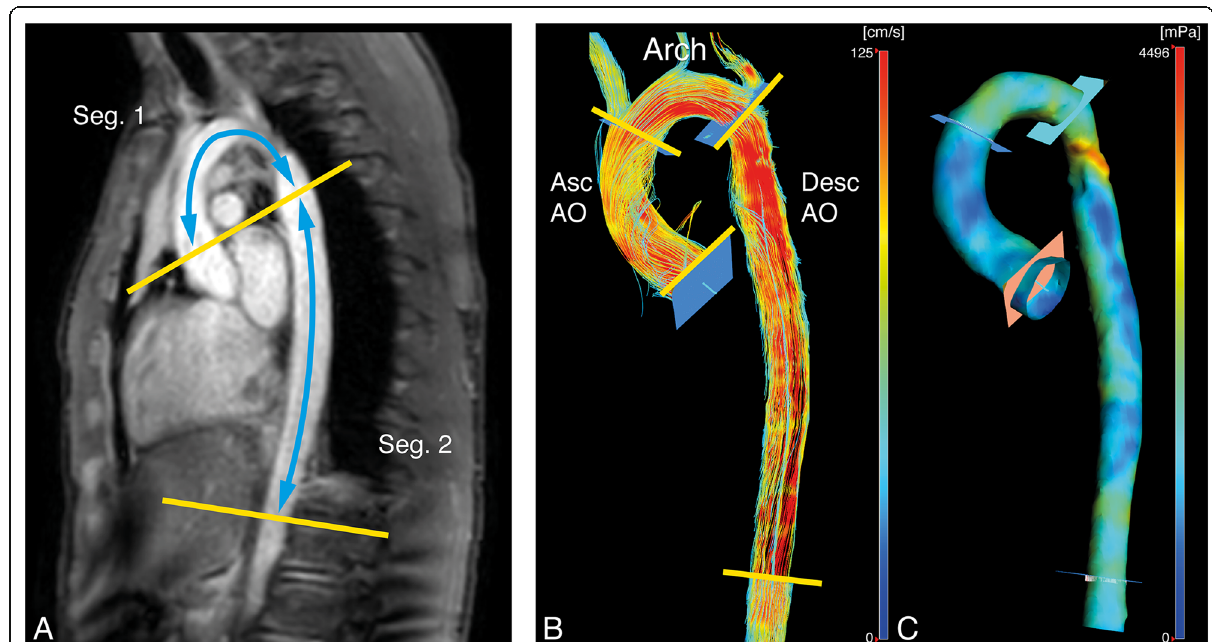
Fig. 1 Example of a patient aortic coarctation and tricuspid aortic valve without reobstruction. a Pulse wave velocity segments (Seg.): 1, proximal aorta; 2, descending aorta. b Wall shear stress segments: Asc AO , ascending aorta; Arch , aortic arch; Desc AO , descending aorta. c Three-dimensional magnitude wall shear stress map